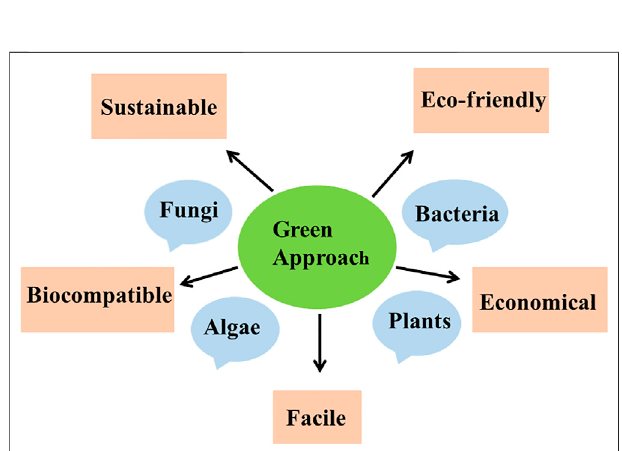
FIGURE 2 | Importance of biological synthesis of nanoparticles by using plants, bacteria, algae and fungi.